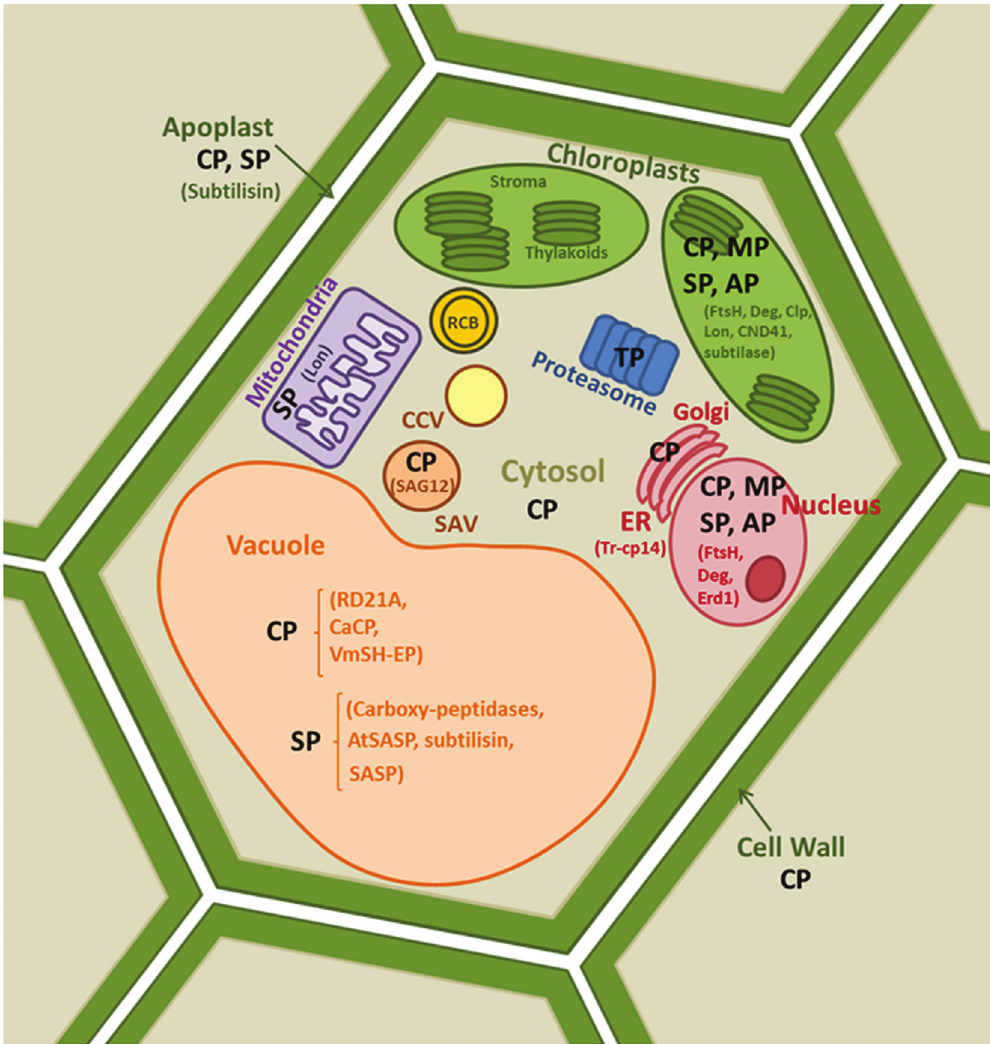
Figure 2 - Location of plant proteases in different cellular compartments involved in plant senescence. Different families of proteases are represented: Cysteine-Proteases (CP), Serine-Proteases (SP), Metallo-Proteases (MP), Threonine-Proteases (TP) and Aspartic-Proteases (AP). Subcellular localiza- tion of specific proteases, indicated in brackets, are in chloroplast (FtsH-, Clp-, Lon-, DegP- CND41- and subtilase-like proteases), vacuole (RD21A, CaCP, VmSh-EP, AtSAP, subtilase-, SASP-like proteases), mitochondria (Lon-like protease), SAV (SAG12-like protease), ER (Tr-cp-14-like protease) and apoplast (subtilisin). Endoplasmic Reticulum (ER), Rubisco Containing Body (RCB), Senescence Associated Vesicle (SAV) and Chloroplast Con - taining Vesicles